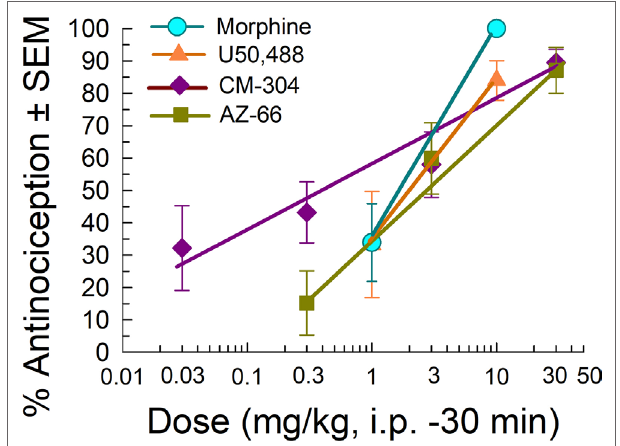
FIGURE 5 | Dose-dependent antinociception of sigma-receptor antagonists CM-304 and AZ-66 following i.p. administration in the mouse acetic-acid writhing assay. Opioid agonists morphine and U50,488 are shown as positive controls. All points represent average response ± SEM at peak effect, 30 min after admin in 8–14